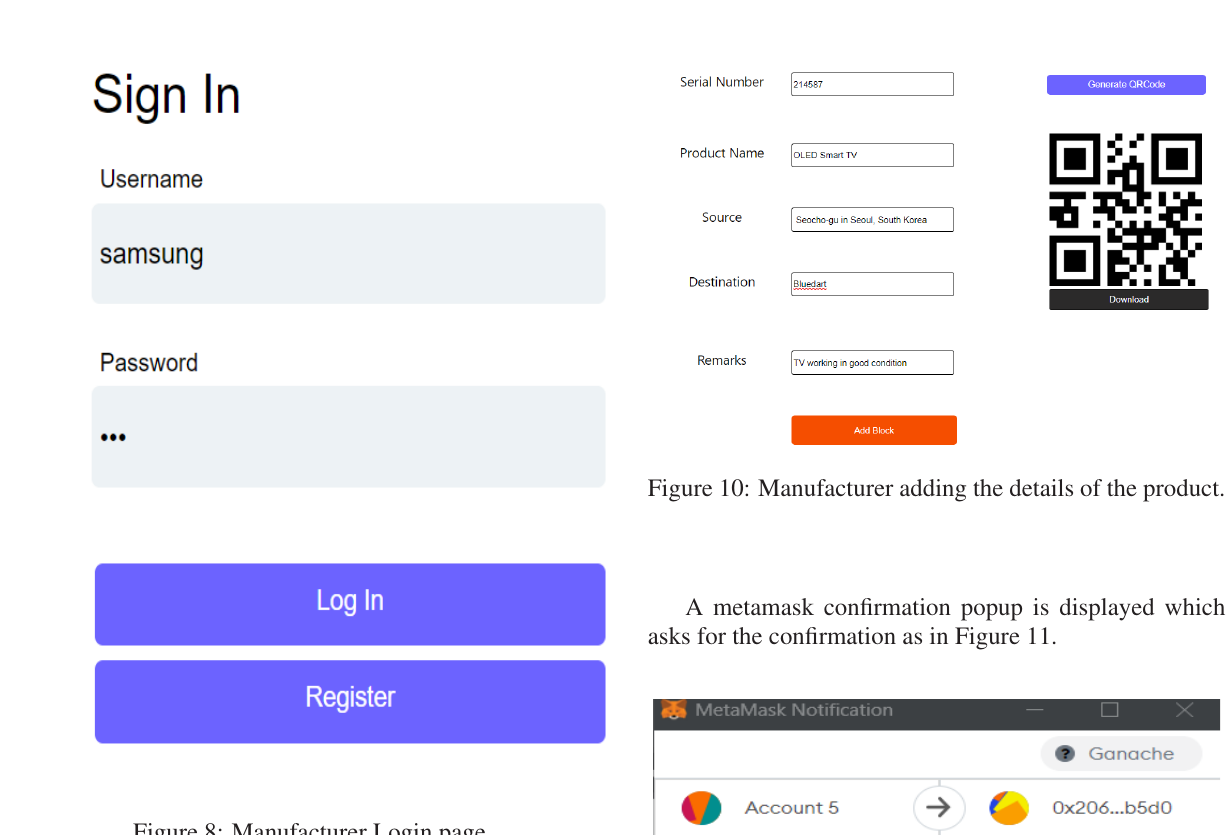
Figure 8: Manufacturer Login page